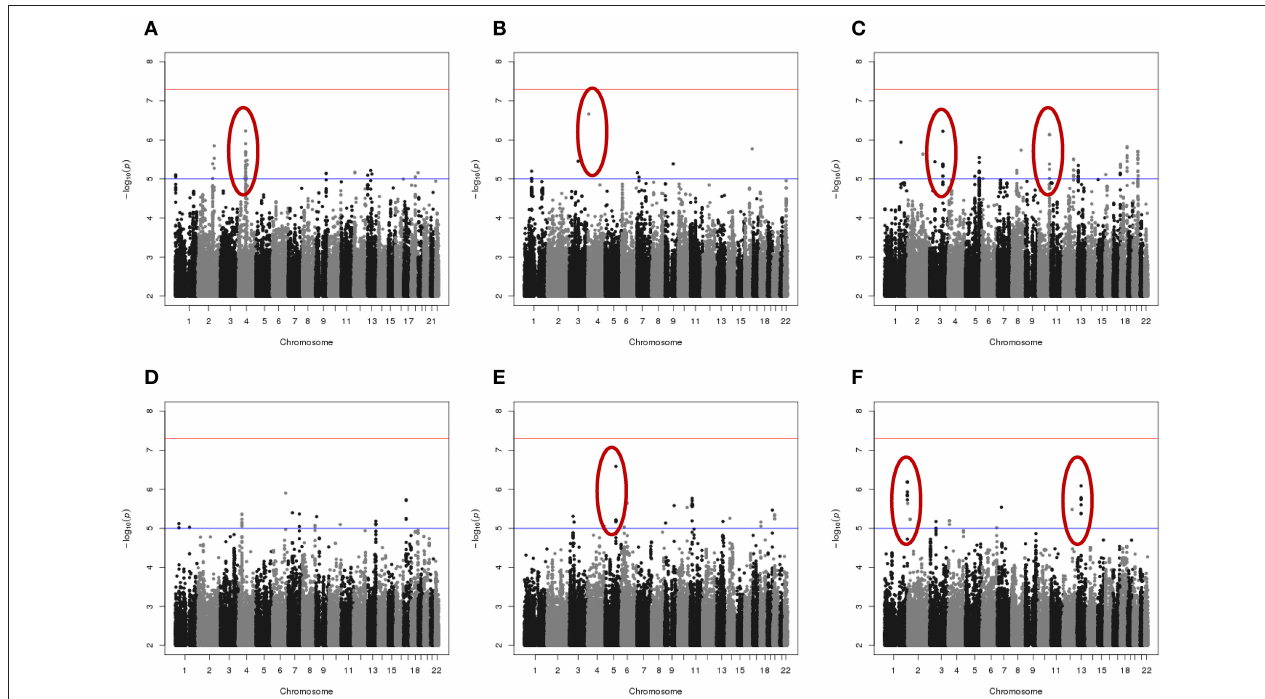
FIGURE 2 | Manhattan plots of the single SNP meta-analysis genome-wide association results based the six in vitro drug response measures among ovarian cancer patient LCLs. (A) Carboplatin MTT; (B) Paclitaxel MTT; (C) Combination of carboplatin and paclitaxel MTT; (D) Carboplatin Caspase3/7; (E) Paclitaxel Caspase3/7; and (F) Combination of carboplatin and paclitaxel Caspase3/7. Blue line indicates p = 0.00001; Red line indicates p = 5 × 10 − 8 . Highlighted regions (circled) are displayed in Figure 3 .